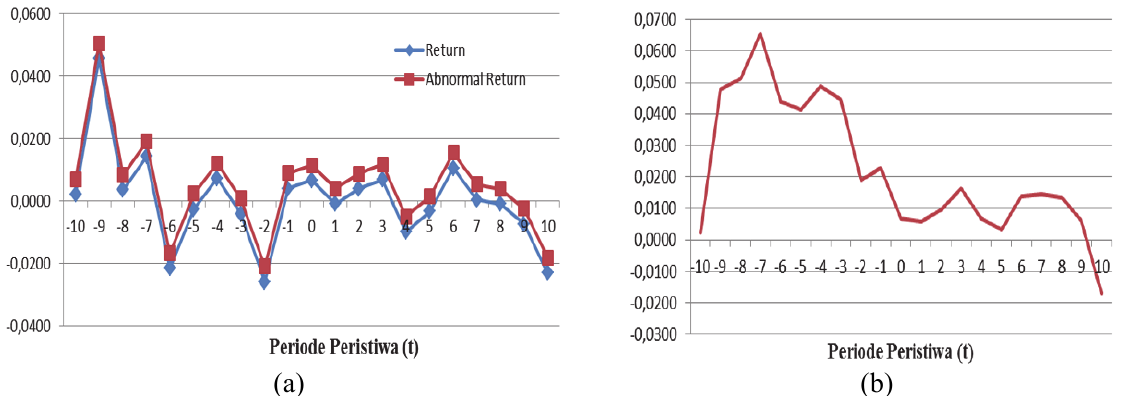
Fig. 2. Movement of (a) Return and Abnormal Return and (b) Cumulative Return on JCI for EPP volume I The CAR value before the event was 2.2%, which decreased to -1.7%. This shows that the